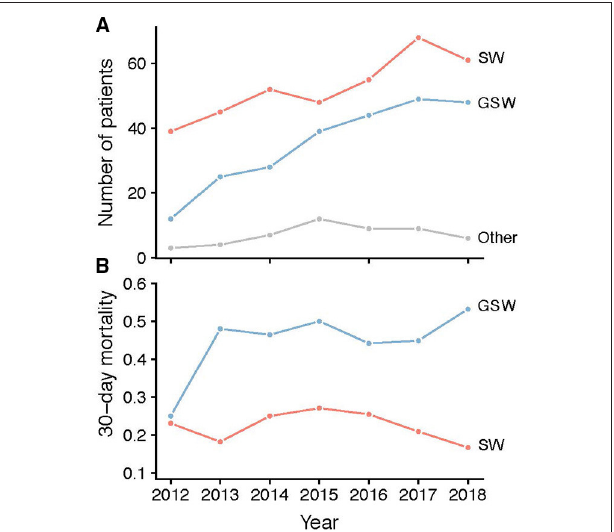
FIGURE 1 | (A) Time development of the number of patients per year with stab wound (red), GSW (blue), or other (gray) trauma mechanisms. (B) Time development of 30-day mortality (fraction) in the stab wound (red) and GSW (blue) subgroups. GSW, gunshot